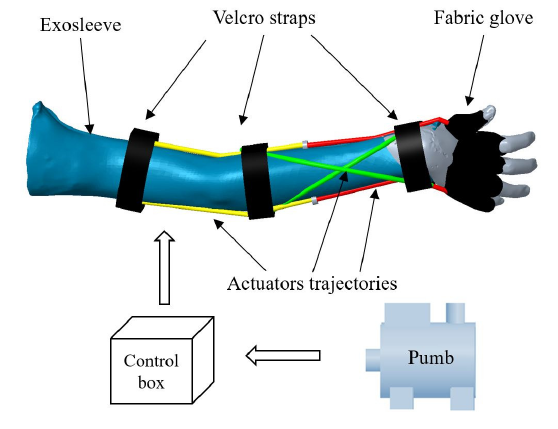
Figure 9. Modular architecture of the MOSAR